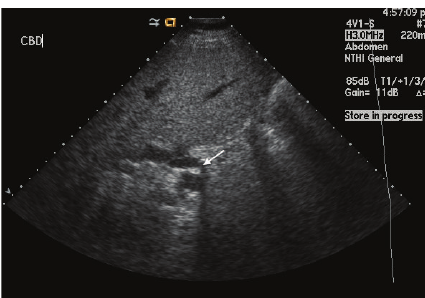
Figure 1: Transabdominal ultrasound of common bile duct (CBD) with CBD stone (arrow) and associated posterior acoustic shadow- ing.